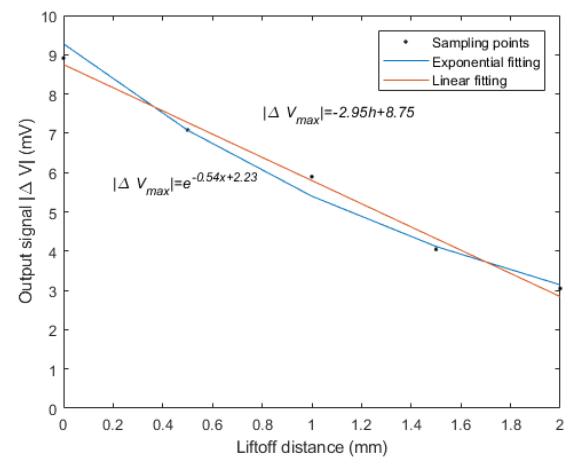
Figure 11. The fitting relationship between the lift off distance and the maximum value of the output signal.